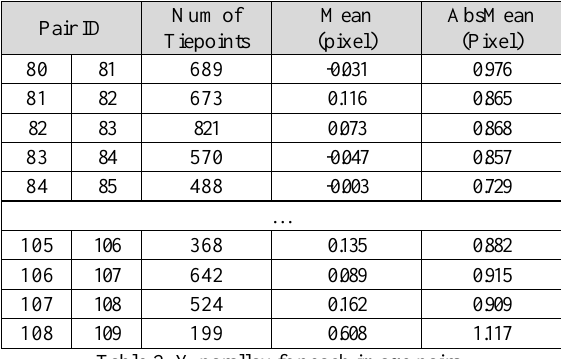
Table 2. Y-parallax for each image pairs